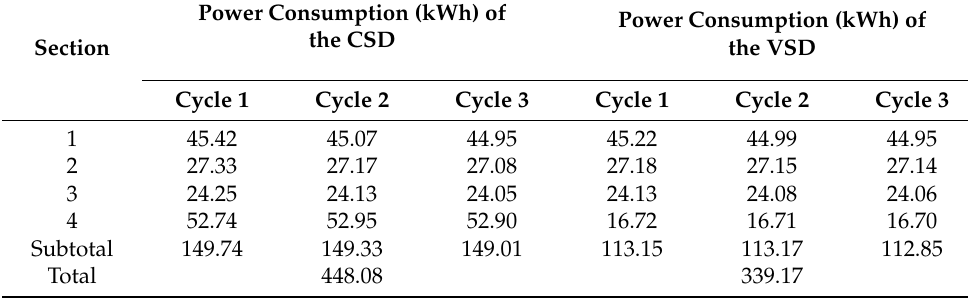
Table 2. Comparison of power consumption according to the CSD and VSD.